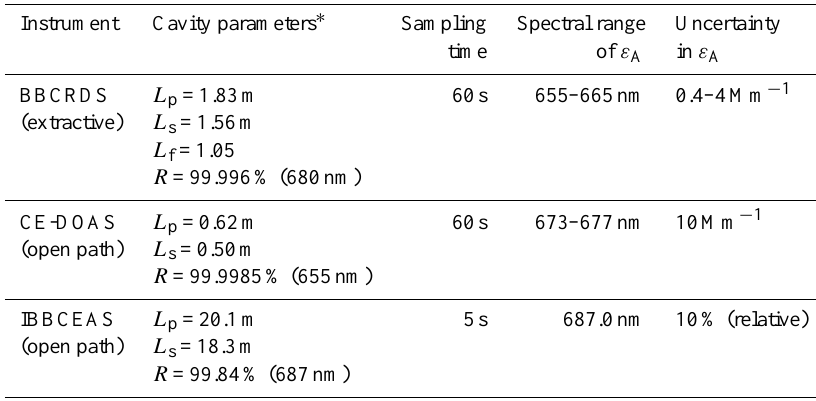
Table 1. Operating parameters of the BBCRDS, CE-DOAS, and IBBCEAS instruments and the wavelength range of the reported aerosol extinction, ε A . Instrument Cavity parameters